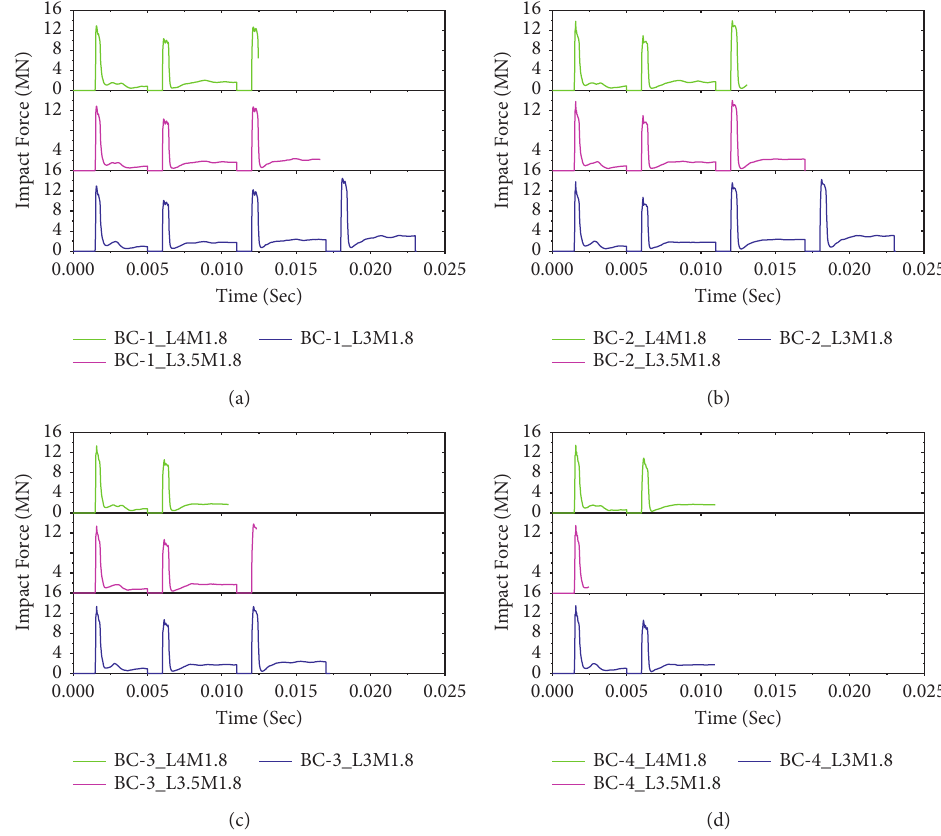
Figure 20: Effect of column height on impact capacity of BRC columns: (a) normal, (b) two-bundle, (c) three-bundle, and (d) four-bundle reinforcement